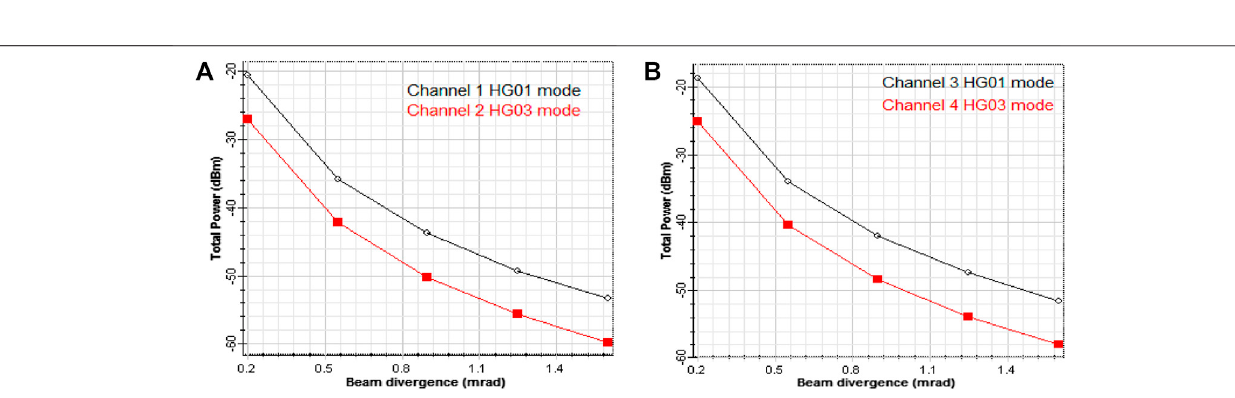
FIGURE 13 | Signal power plots for (A) 1931. THz channel and (B) 193.2 THz channel under the effect of the beam divergence angle.